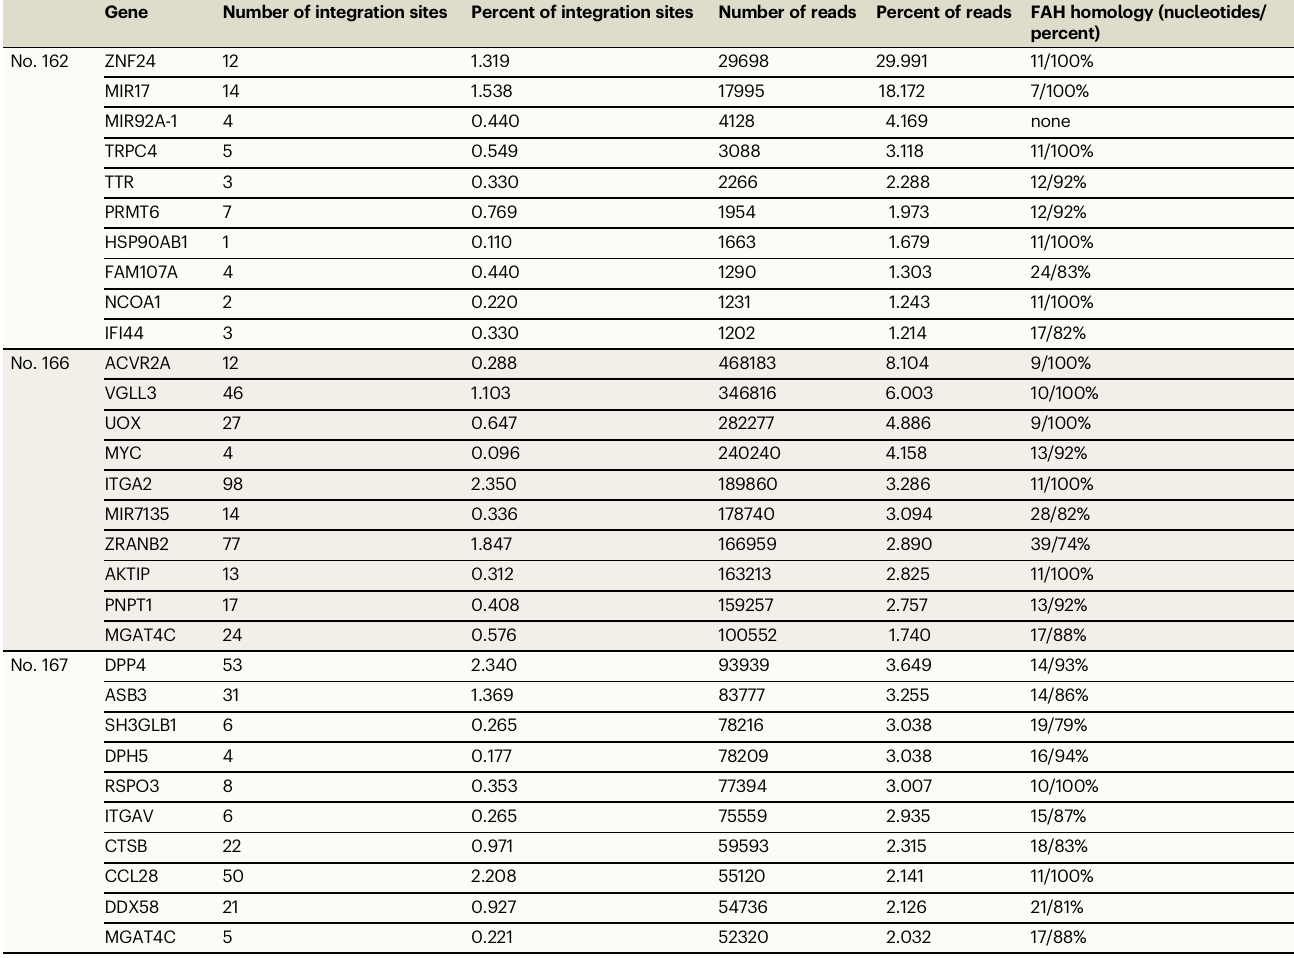
Table 2 | Top 10 genes by integration frequency